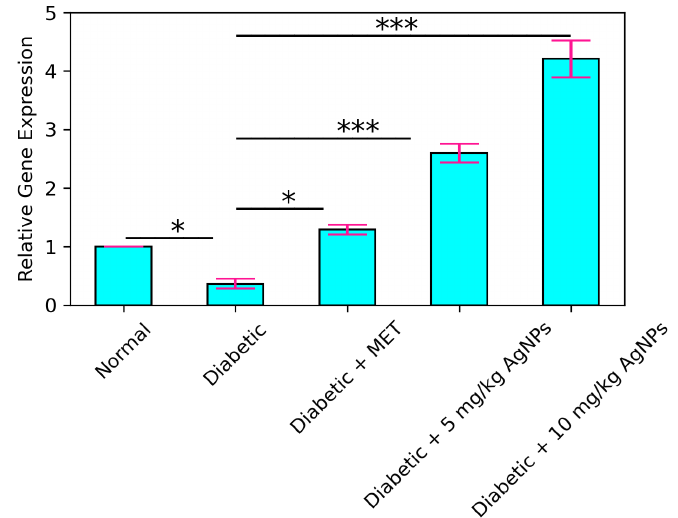
Figure 17. Relative expression of IRS1 in control, diabetic, and metformin- and AgNPs-treated (28 days) groups. Significance was determined by One Way ANOVA following Bonferroni’s Multiple comparison Post Hoc Test. Error bars represent the SEM (standard error of the mean) (* p < 0.05, *** p < 0.001).